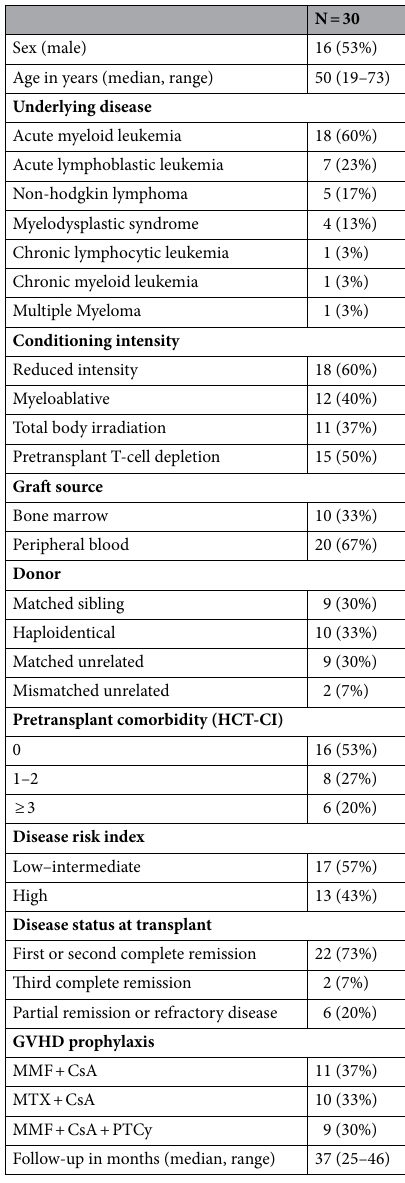
Table 1. Clinical characteristics of the study patients. MMF mycophenolate mofetil, MTX methotrexate, CsA cyclosporin A, PTCy post-transplant